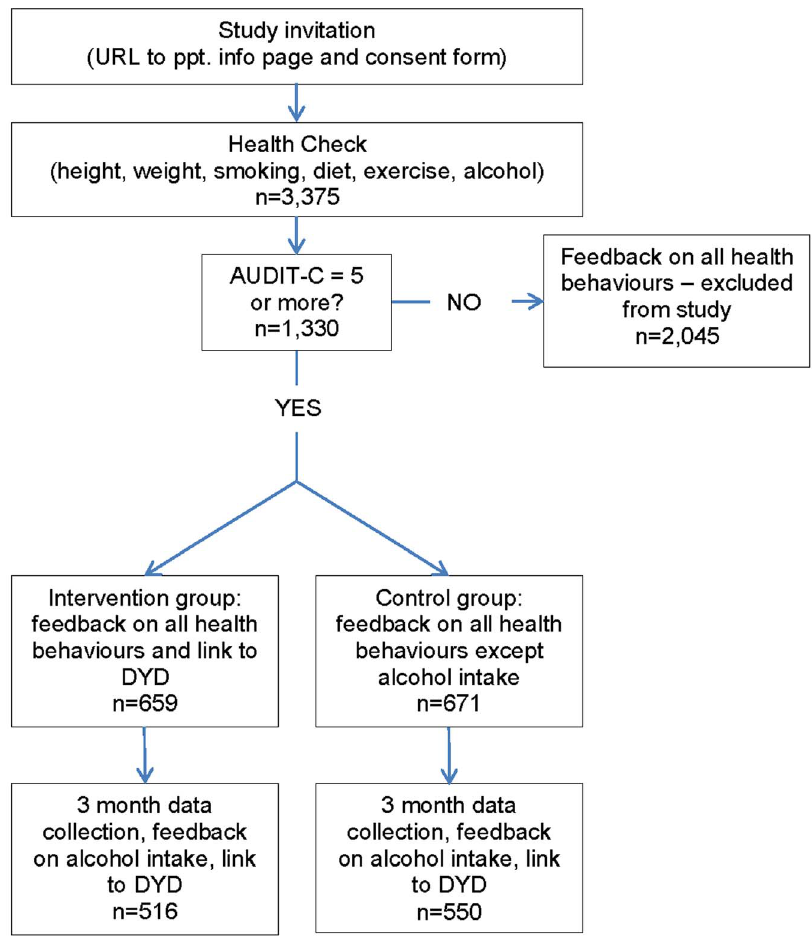
Figure 1. Consort diagram.